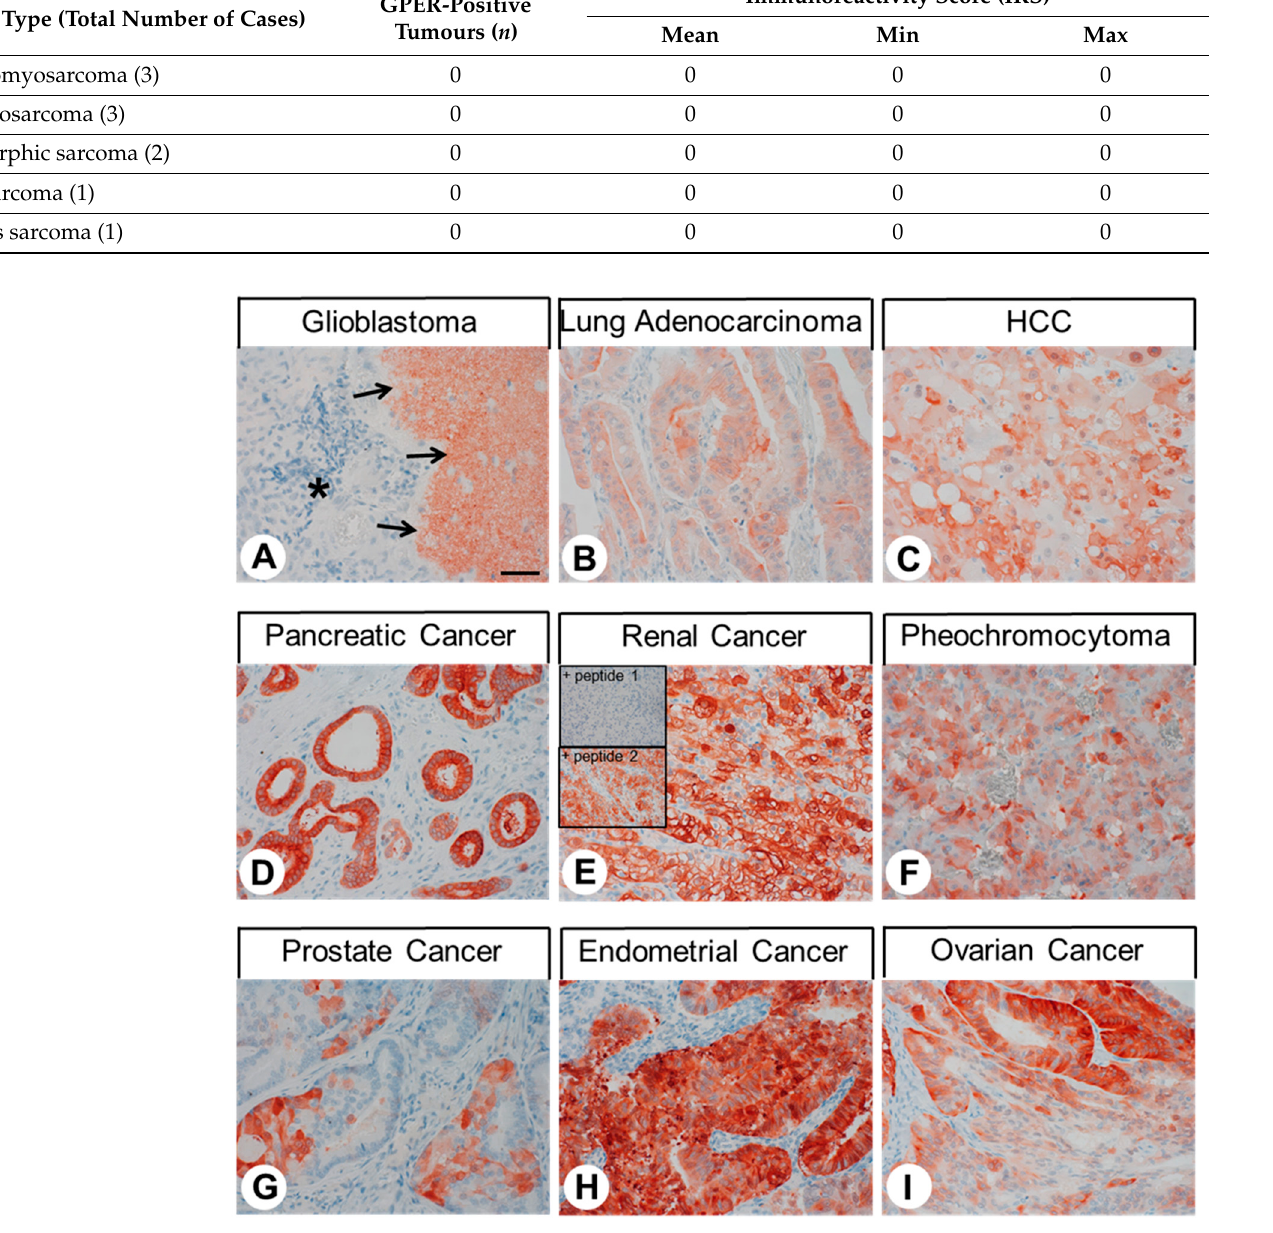
Figure 5. Immunohistochemical detection of GPER localisation in different human tumour entities. Immunohistochemical staining (red-brown colour) and counterstaining with haematoxylin. Scale bar: 100 µm ( A – I ). Insets in E represent adsorption controls, in which the anti-GPER antibody 20H15L21 was preincubated for 2 h with either the peptide used to immunise the rabbit (+ peptide 1) or with a peptide representing an amino acid sequence at the N-terminal region of the receptor (+ peptide 2). Asterisk in ( A ), tumour; arrows in ( A ), surrounding GPER-positive non-neoplastic cortical tissue.